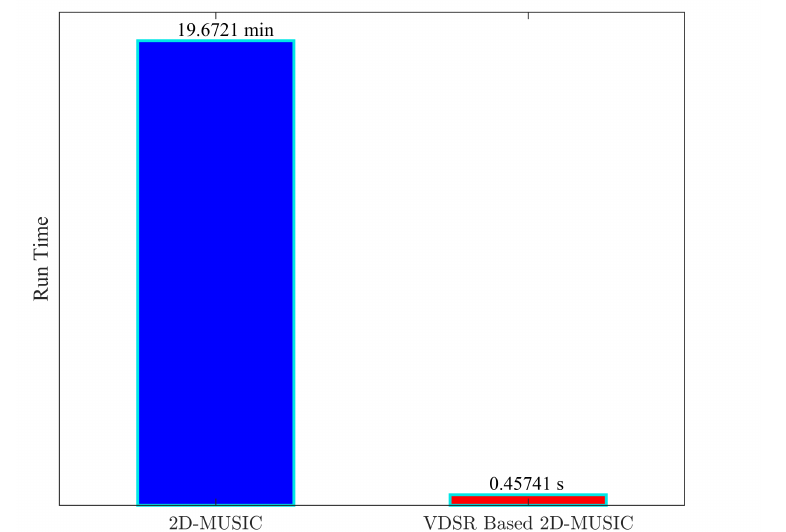
Figure 18. Experimental runtime.